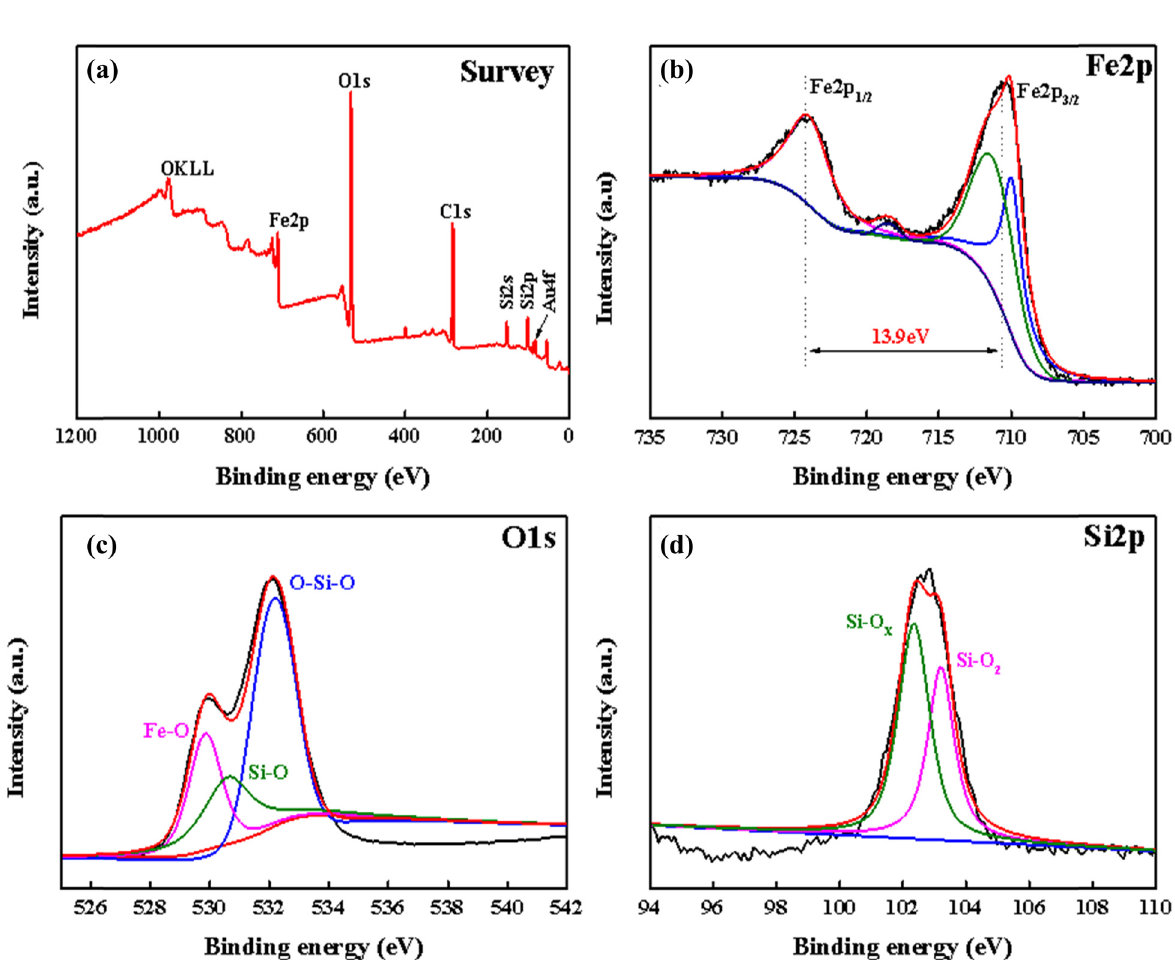
Figure A1: XPS spectra of the as - prepared FSA - MIPs: ( a ) survey, ( b ) Fe 2p, ( c ) O 1s, ( d ) Si 2p, ( e ) Au 4f, and ( f ) C